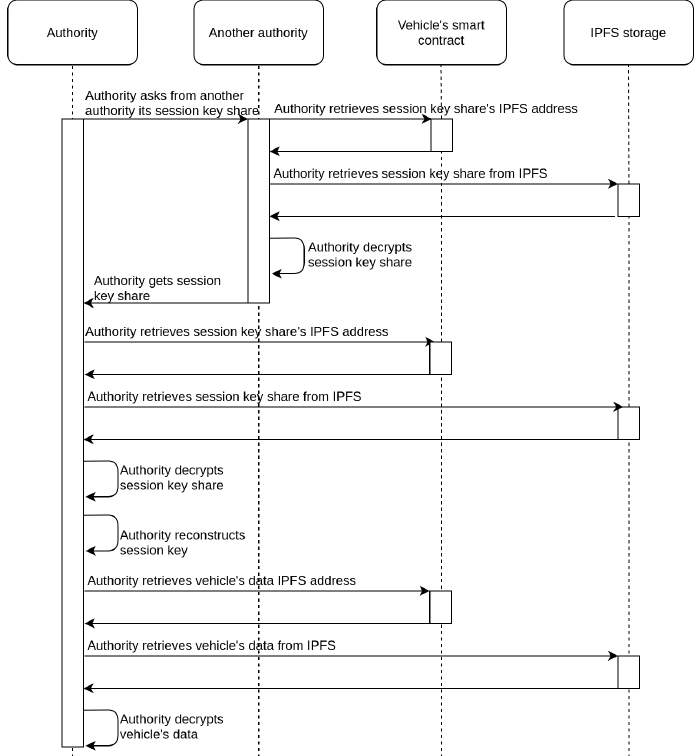
Figure 5. Sequence diagram for retrieval of data without the consent of the vehicle